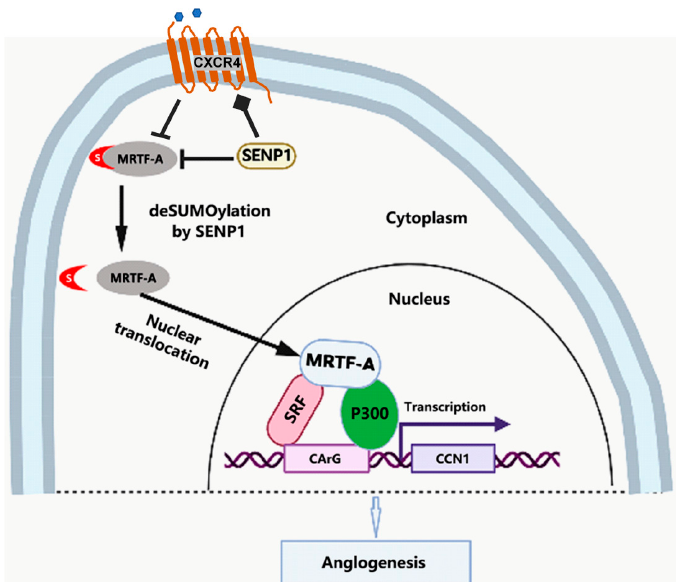
Figure 6. A model for the regulation of MRTF-A by SUMOylation. MRTF-A is sequestered in the cytoplasm by SUMOylation in MSCs. When there is a need for differentiation toward angiogenesis, SENP1 is activated by certain regulation factors to induce MRTF-A deSUMOylation, which makes MRTF-A relocate into the nucleus. By cooperating with P300 and SRF on the CArG box, the angiogenic factor CCN1 is transactivated and initiates the angiogenesis process. CXCR4 likely plays a regulatory role on upstream of MRTF-A SUMOylation, but the detailed interactions are yet to be elucidated.